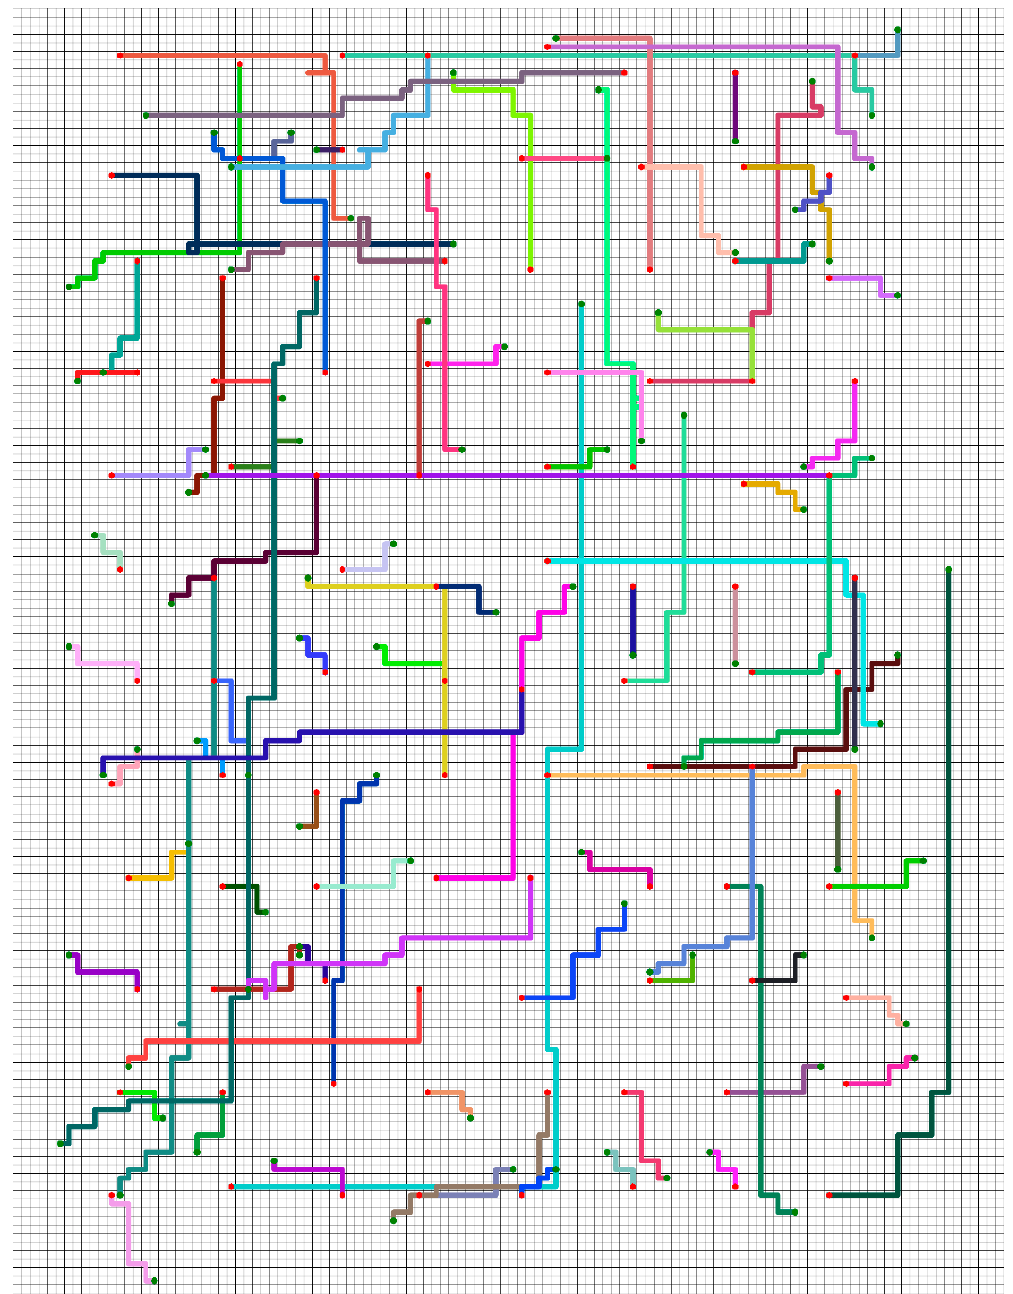
Figure 9. The trajectories of using Policy_2 to guide 96 robots to complete tasks in the large-scale grid map workspace. Different colors indicate the trajectories of different robots. The red hexagon is the initial position, and the green dot is the target position.